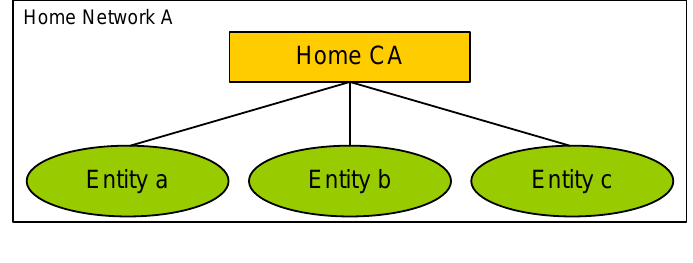
Figure 1. Simple certificate hierarchy inside home networks: the Home CA issues certificates to